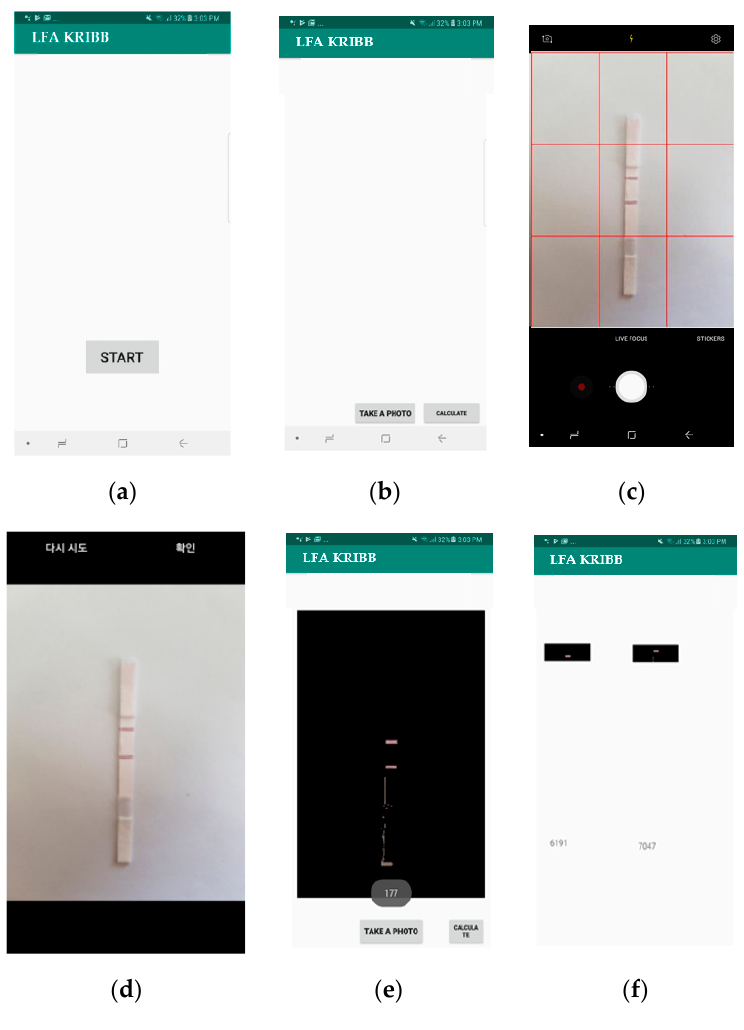
Figure 12. Proposed application for the detection of an analyte in an LFA strip: ( a ) home screen, ( b ) second screen with an image capture option, ( c ) camera view with a 3 × 3 grid spacing, ( d ) captured raw image, ( e ) processed image using the created mask (total pixel number shown at the bottom of the image), and ( f ) calculated control (left) and test (right) line weighted sum of pixels’ intensity values.